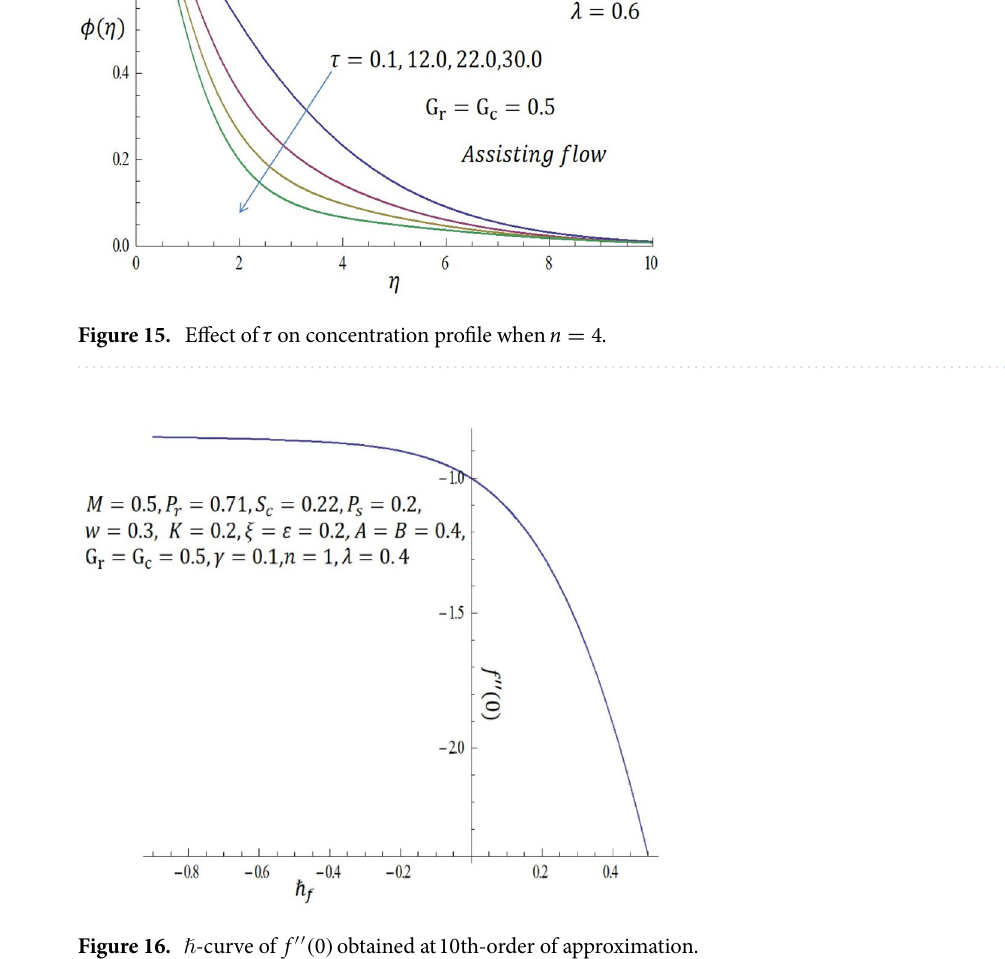
Figure 16. ℏ -curve of f ′′ ( 0 ) obtained at 10th -order of